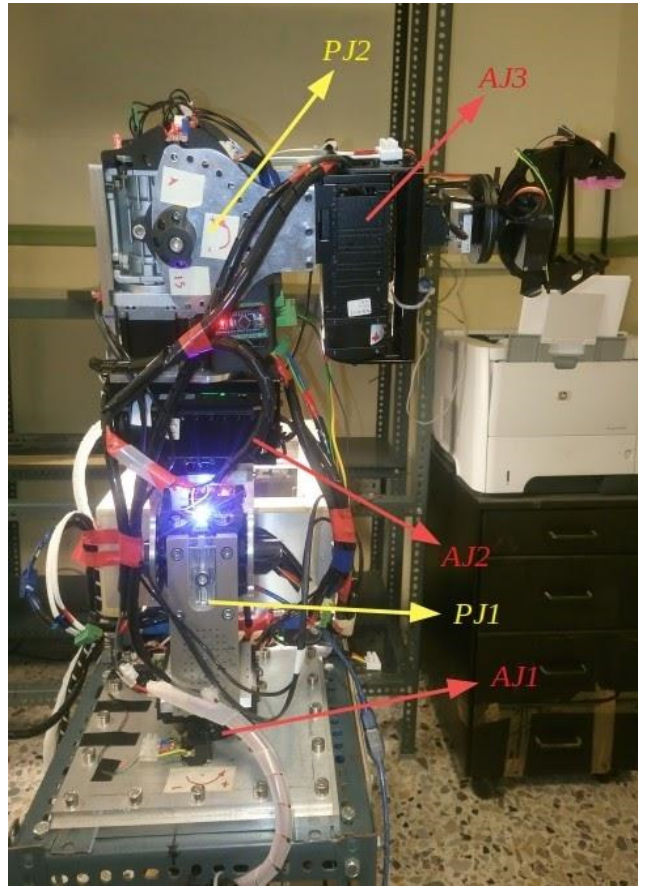
Figure 3. The SMM prototype used in this research. (All AJ and PJ1 are at zero position, and PJ2 is set to − 1.5708 rad.)